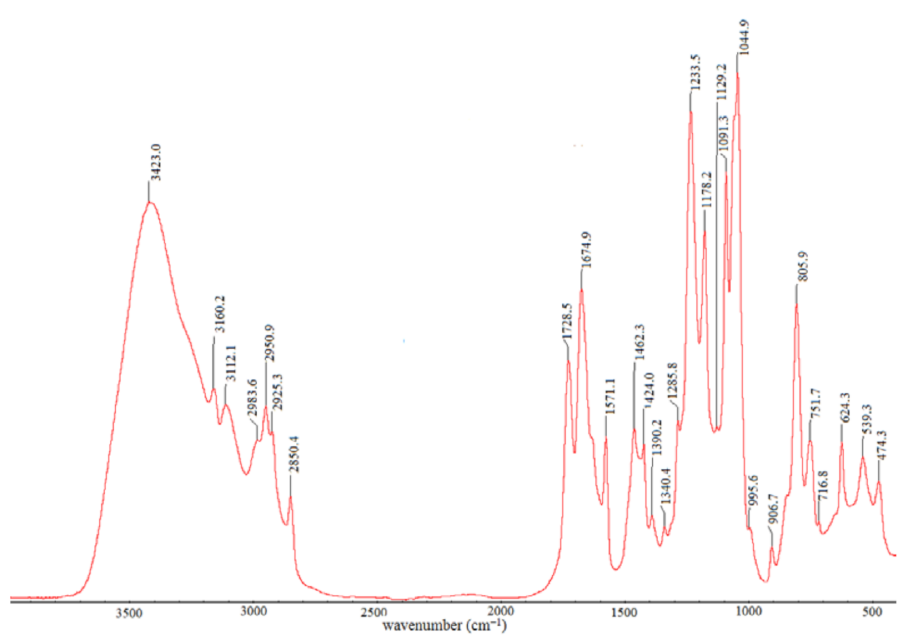
Figure 4. FTIR spectrum of a copolymer synthesized at a molar ratio of VP/GMA in the reaction system 0.89, registered in potassium bromide tablets.